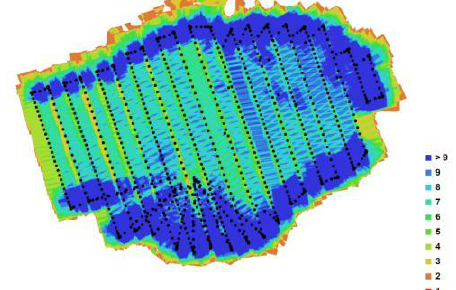
Figure 3. Camera positions and image overlaps. The legend on the right represents the number of images in which a point appears.